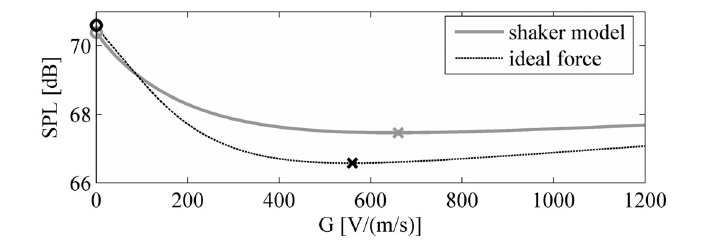
Fig. 12. Sound pressure level at driver’s head position: (o) passive and (x) optimal